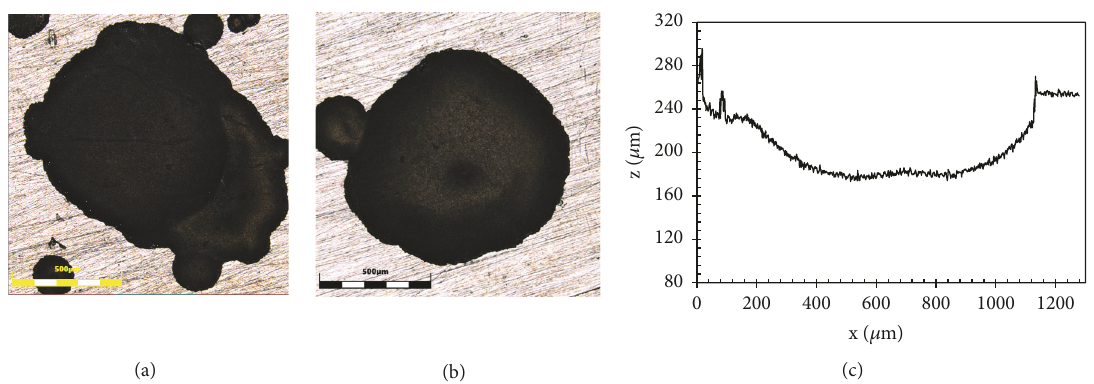
Figure 12: CLSM micrographs for a representative untreated sample ((a) and (b)); (c) the transverse profile for the pit shown in (b).